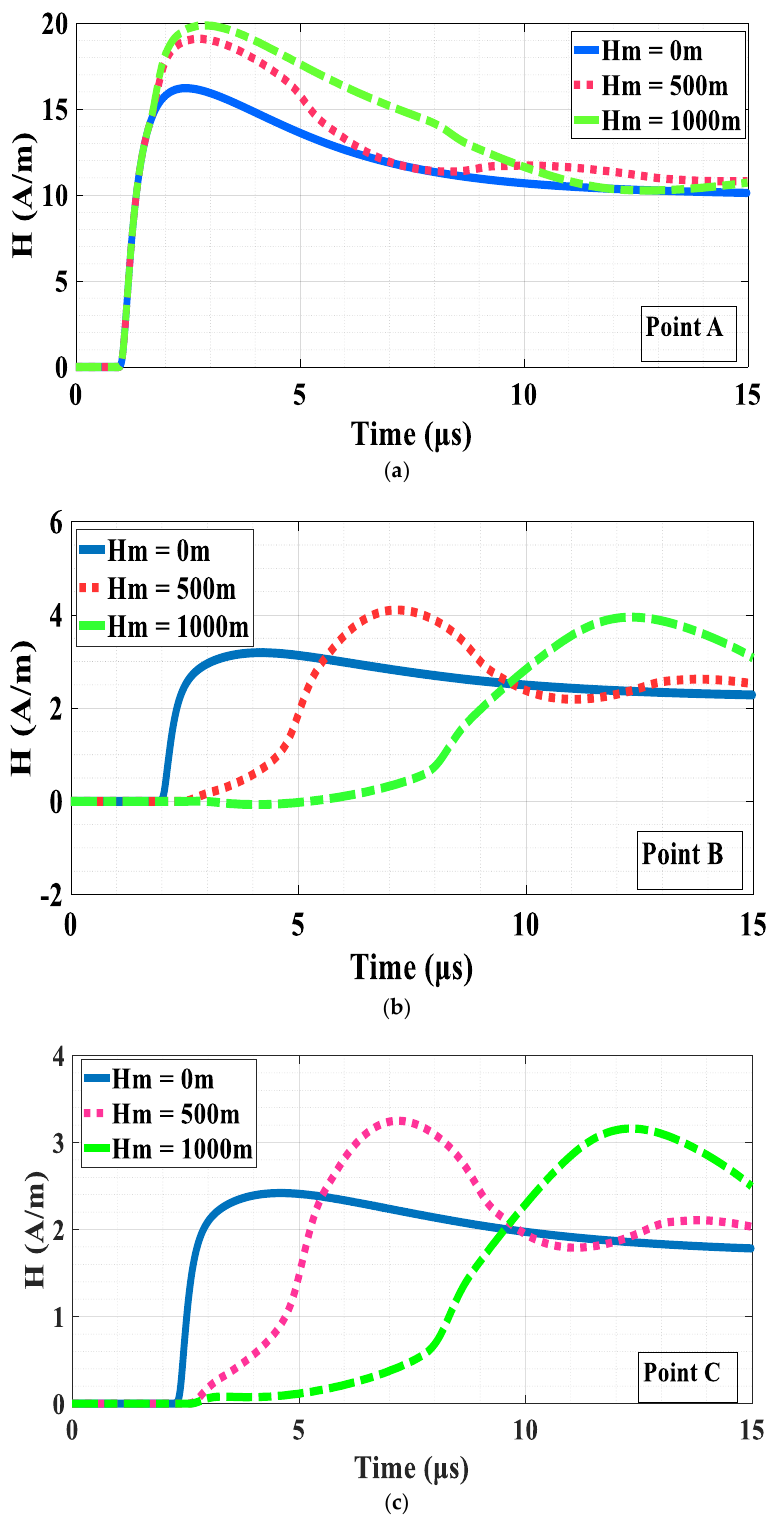
Figure 8. Horizontal magnetic field ( H y ) associated with a subsequent return stroke at the considered 3 observation points A ( a ), B ( b ), C ( c ), and considering different mountain heights (H m = 0, 200, 500, observation points A ( a ), B ( b ), C ( c ), and considering di ff erent mountain heights ( H m = 0, 200, 500, and 1000 m). and 1000